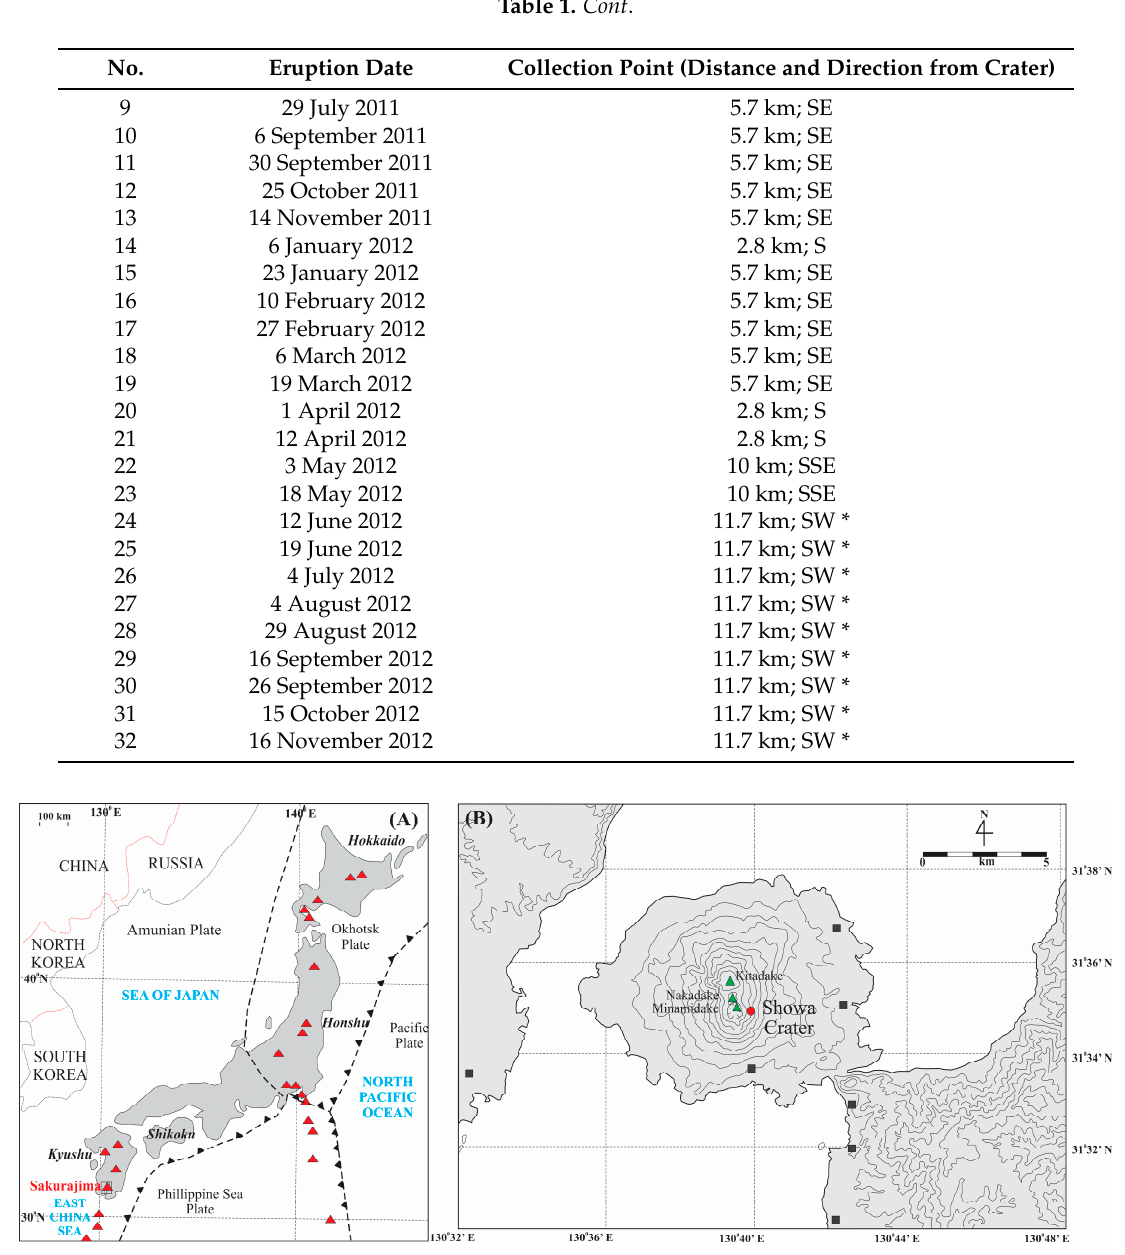
Figure 1. ( A ) Index map Japan; ( B ) location sampling map (solid rectangle).